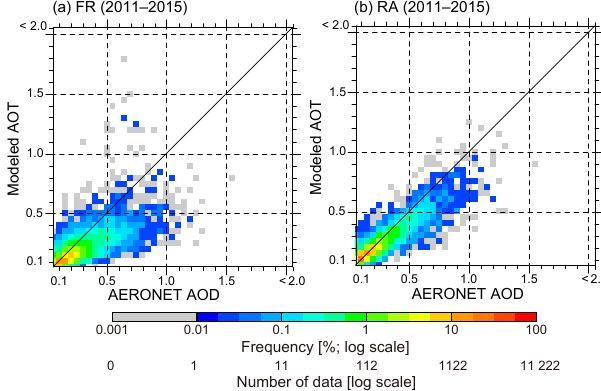
Figure 13. Frequency of deviations (observed AODs minus mod- eled AODs) from the 1h binned AERONET AOD. The percent- ages of deviations between − 0.05 and + 0.05 ( − 0.10 and + 0.10) are shown at the top left (top right), and the percentages less than − 0.5 (bottom left) or greater than + 0.5 (bottom right) are shown in parentheses.